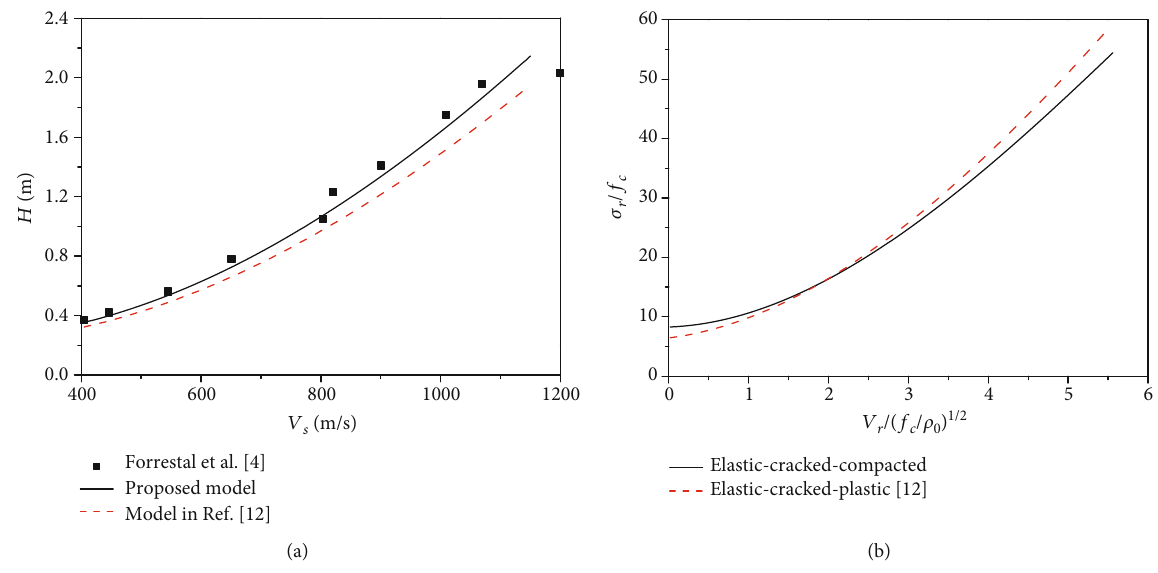
Figure 4: Model veri fi cation for 51MPa concrete: (a) comparison of predicted and experimental DOP and (b) cavity surface radial stress calculation results of the elastic-cracked-compacted and elastic-cracked-plastic